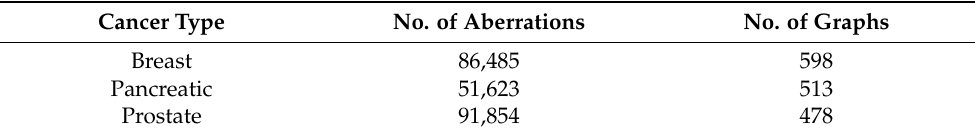
Table 1. The size of the data used in the experiment (number of aberrations and resulting graphs for integrated inter-/intrachromosomal